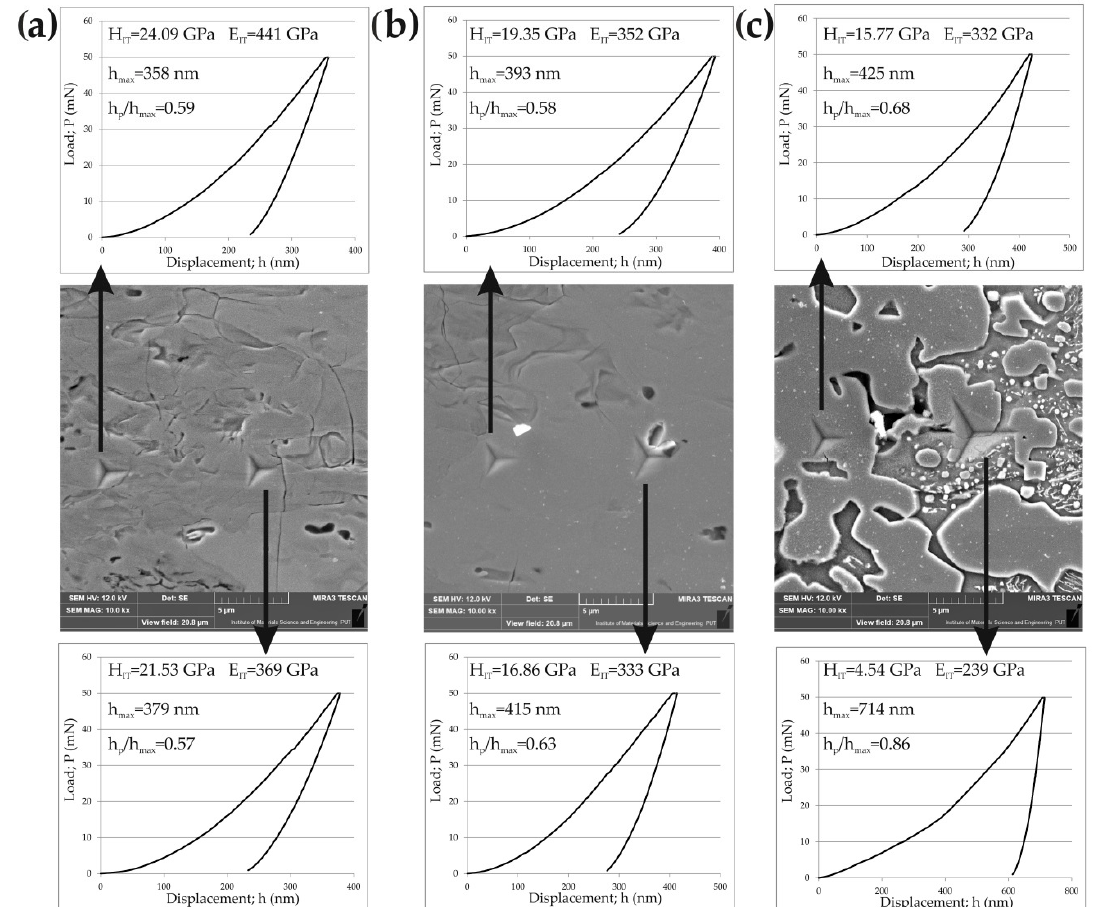
Figure 16. SEM images of X165CrV12 steel after powder-pack boriding at the temperature of 1223 K for 9 h with visible selected indents and the results of nanoindentation performed in: ( a ) outer FeB zone, ( b ) inner Fe 2 B zone and ( c ) transition zone.